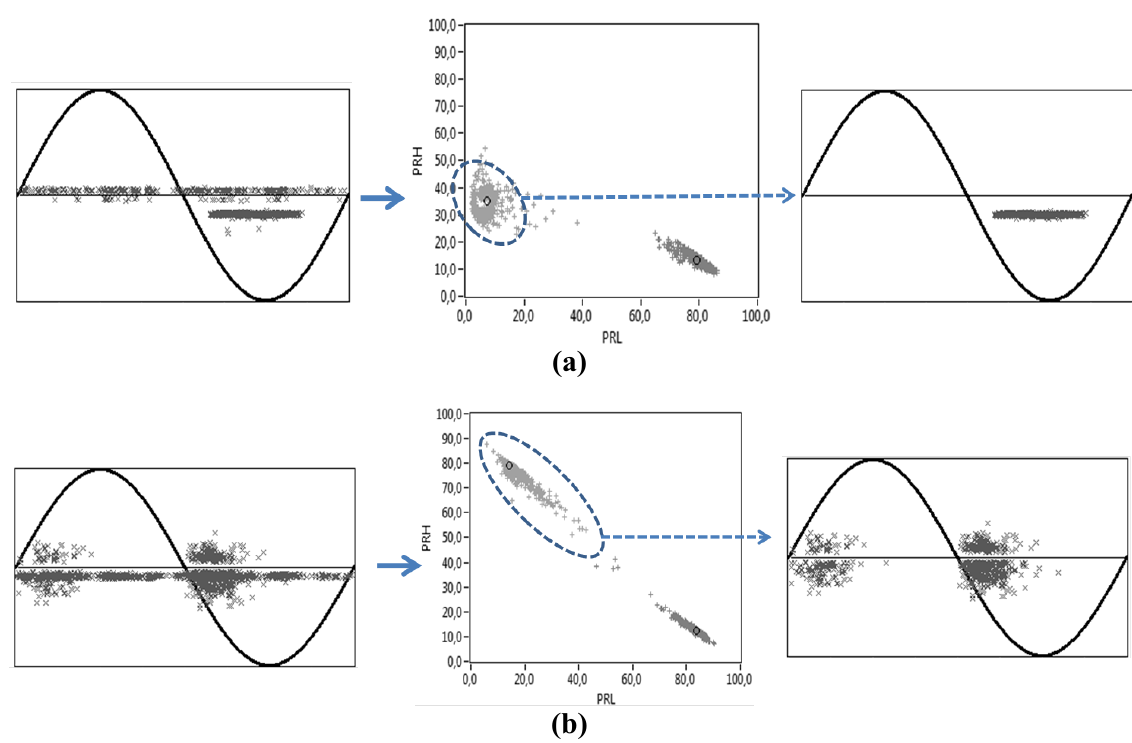
Figure 14. Complete PRPD pattern (Left), PR map (Center) and filtered PRPD (Right) obtained with the ILS sensor for ( a ) corona discharges and ( b ) internal